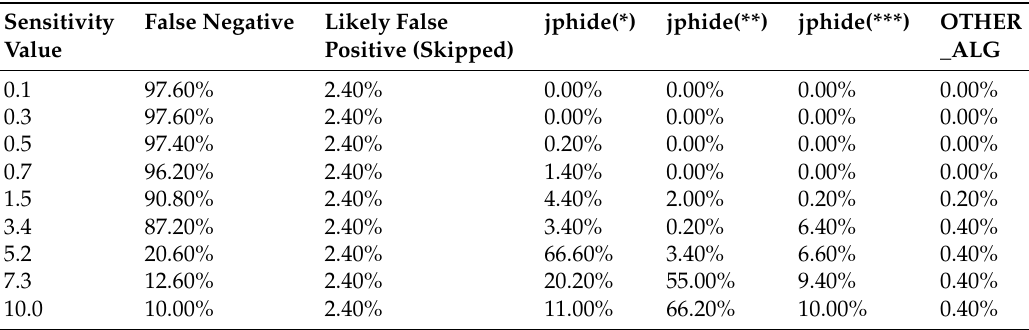
Table 4. Results of 500 images from seam carve untouched images with different sensitivity values.